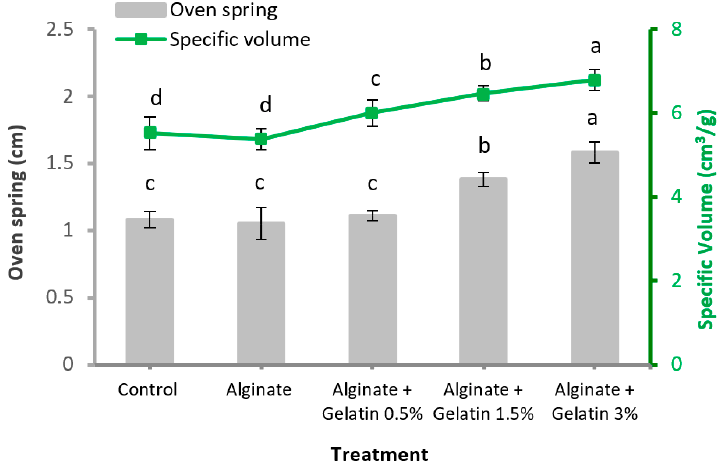
Figure 2. Oven spring and specific volume of bread supplemented with encapsulated L. acidophilus in different matrices. Means ± SD with different letters in the same column or line represent significantly different ( p > 0.05)